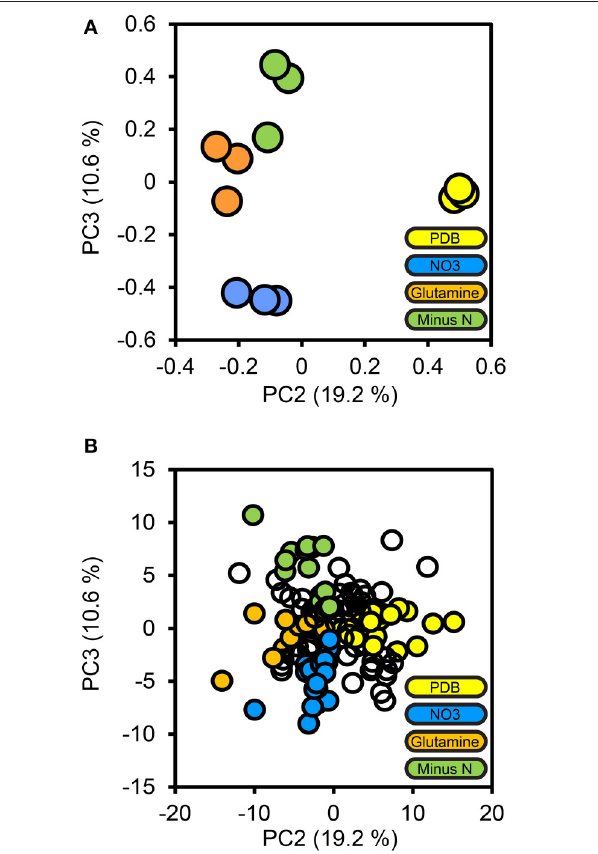
FIGURE 4 | Principal components analysis of the high confidence secretome. Protein LFQ abundances for the 134 protein high confidence secretome subset were subjected to principal components analysis. The PCA scores plot for PC2 and PC3 are shown in (A) , with one marker drawn per biological replicate. The percentage of the total variance explained by each principal component is shown in brackets on each axis. Individual protein loadings for PC2 and PC3 are shown in (B) , with one marker per protein, proteins we considered to be most influential for each treatment medium are colored according to that medium, the remainder are drawn as empty